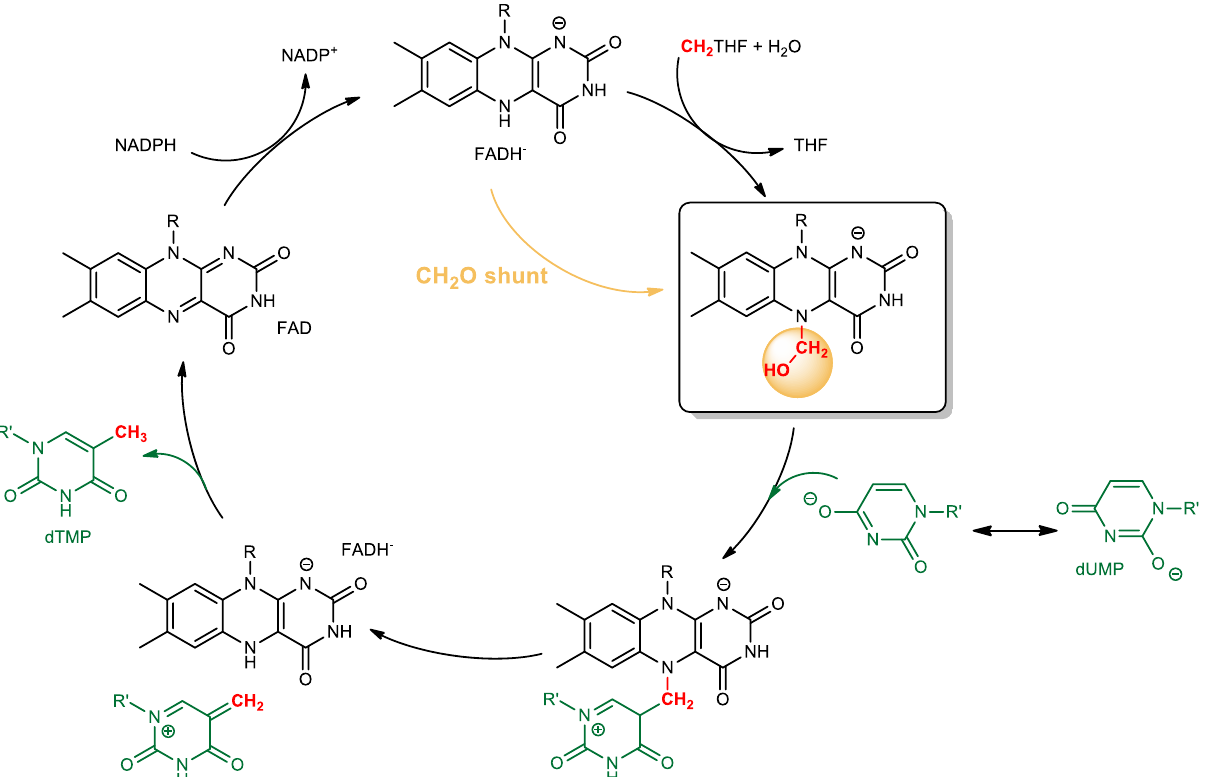
Fig. 4 Proposed chemical mechanism for ThyX. FAD is fi rst reduced by NADPH. Then, the reduced fl avin, FADH − , reacts with the CH 2 THF to form a carbinolamine fl avin, which acts as the genuine methylene donor. The fl avin carbinolamine can be obtained directly via a CH 2 O-shunt reaction consisting of a reaction of FADH − with free CH 2 O. Methylene transfer from FAD to dUMP is initiated by an SN 2 reaction of activated dUMP and the fl avin carbinolamine, leading to water elimination and formation of a transient FAD-CH 2 -dUMP